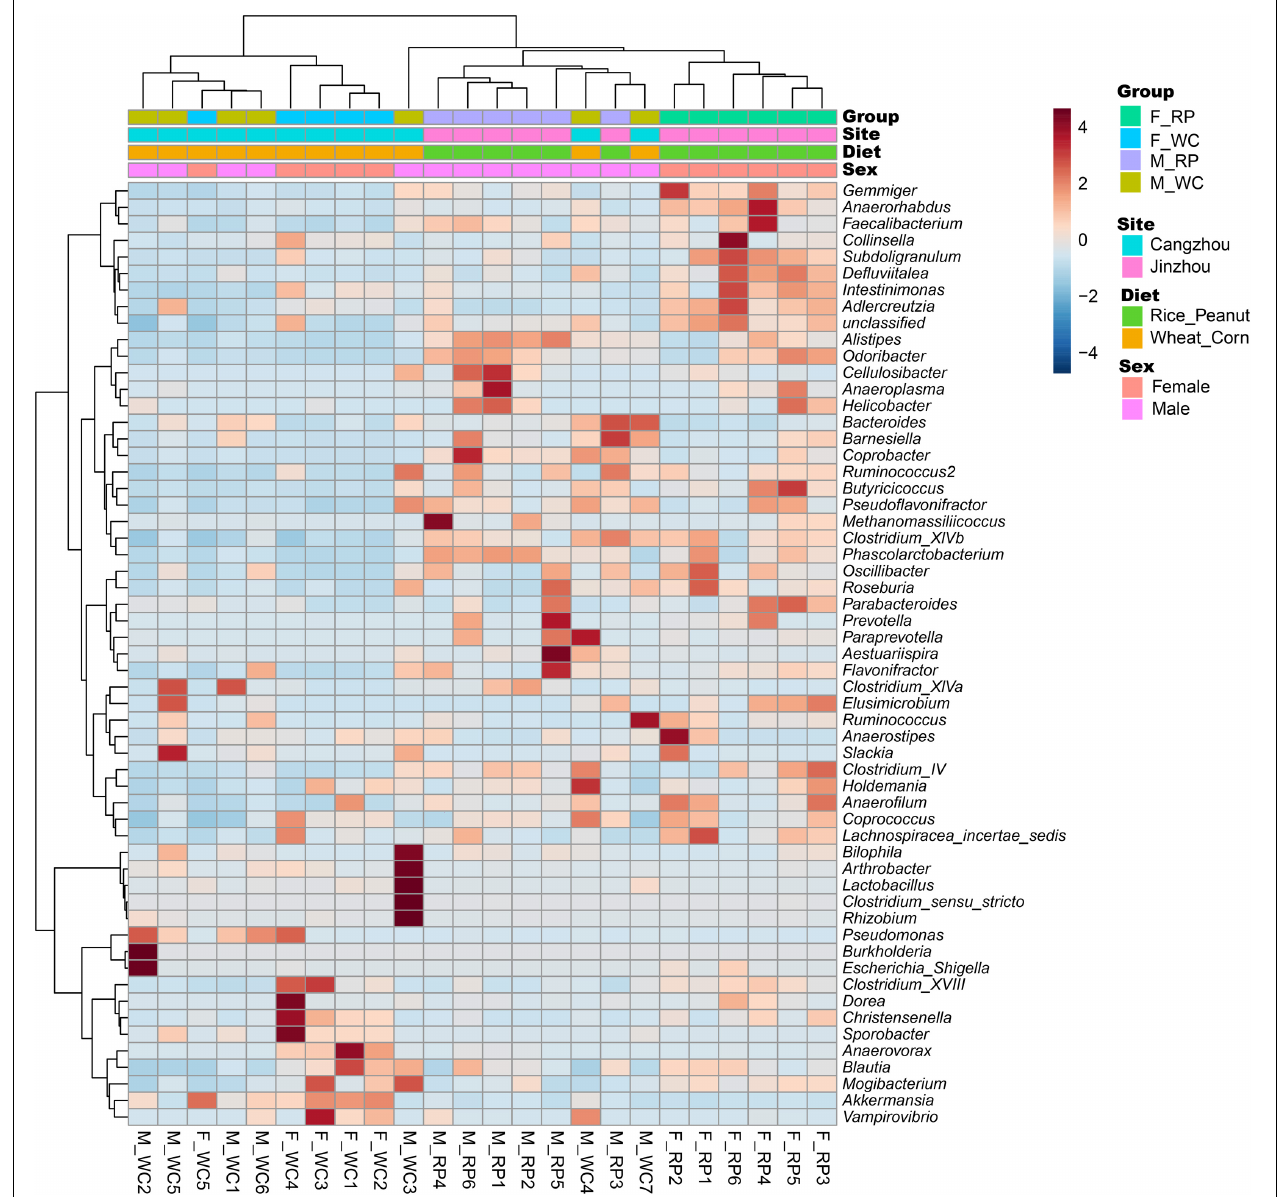
FIGURE 5 | Heatmap showing the relationship between samples based on standard Pearson correlation distance. The tree shown on the left side of the figure depicts hierarchical clustering based on Ward clustering algorithm, and the tree on the top presents samples clustered by the same algorithm. F_RP: females with Rice_Peanut diet, M_RP: males with Rice_Peanut diet, F_WC: females with Wheat_Corn diet and M_WC: males with Wheat_Corn